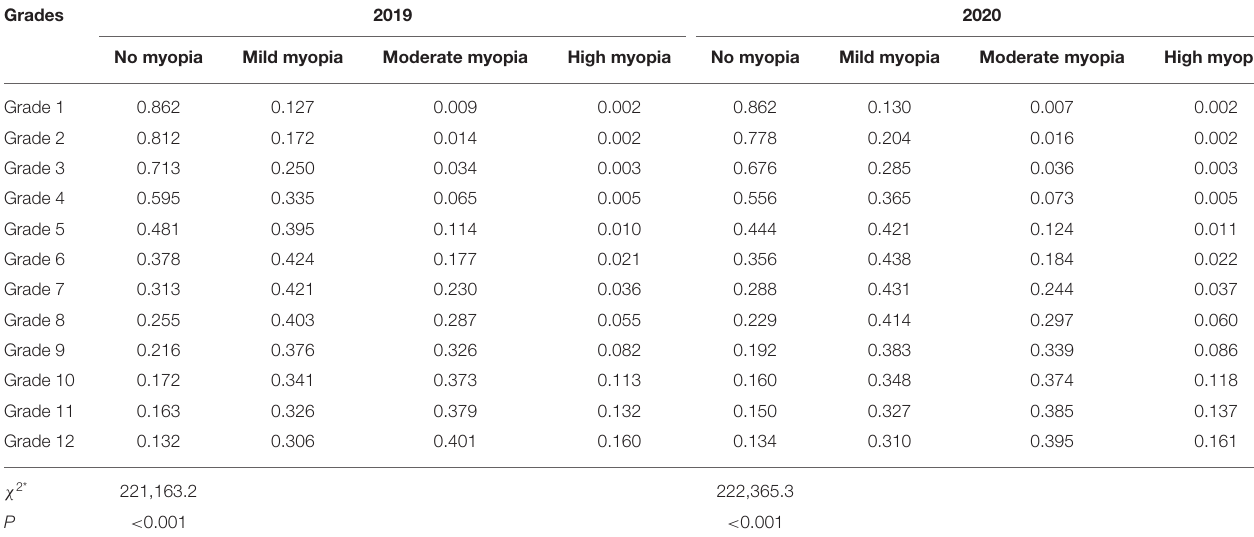
TABLE 2 | The prevalence of myopia of primary and secondary school students in Shenzhen, China according to school grade.